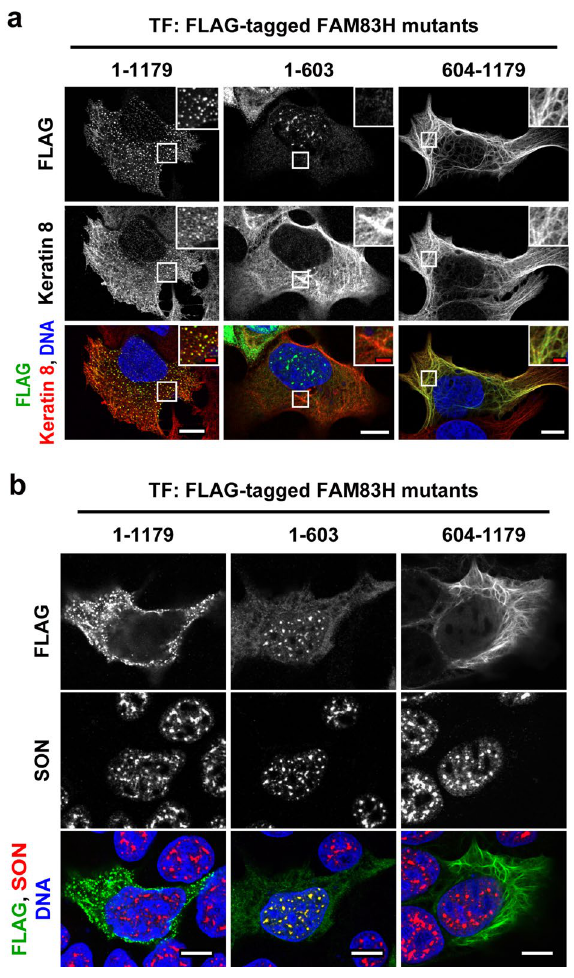
Figure 1. The C-terminal half of FAM83H is required for its localization in the keratin cytoskeleton. DLD1 cells were transfected with the plasmids encoding the indicated FAM83H mutants and were analyzed via immunofluorescence using antibodies for ( a ) FLAG (green) and keratin 8 (red) or ( b ) for FLAG (green) and SON (red). Nuclei were visualized by DAPI (blue). ( a ) Magnified images at the regions enclosed by the white squares are shown. White and red scale bars indicate 10 and 2 μm,